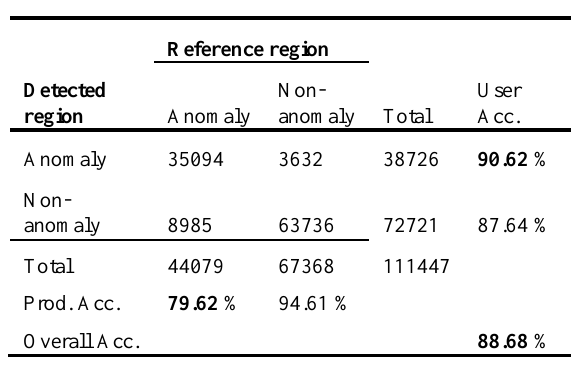
Table 1. Confusion matrix of the detection results in Figure 2(i) in comparison with the reference anomaly region.